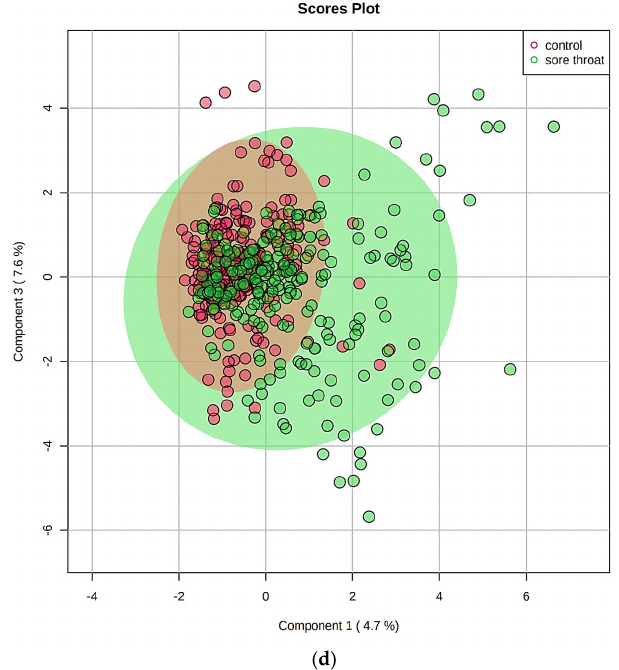
Figure 6. ( a ) and ( b ), 3D component 3 vs. component 2 vs. component 1 PLS-DA scores plots of the TSP-normalised 1 H NMR WMS supernatant dataset for exploring distinctions between participants with an acute sore throat condition (green crosses) and those in an age-matched healthy control cohort (red triangles); in total, 240 samples from each group were analysed, i.e., 5 sequentially collected daily samples from each of 48 participants per group. A total of 31 assigned and named biomolecule predictor variables were incorporated into this experimental design (Model 1). In ( a ), row-wise product quotient normalisation (PQN), with glog-transformation and column-wise Pareto-scaling were applied prior to analysis; ( b ), as ( a ), but with constant sum normalisation (CSN) applied in place of PQN. The % variance contributions for each PC are indicated for each model. ( c ), as ( a ), but with 183 ISB variables. ( d ), 2D component 3 vs. component 1 sPLS-DA scores plot of the complete 183 ISB variable 1 H NMR dataset for a model featuring 10 ISB predictor variables per component for a maximum number of 4 components (PQN, glog-transformation and Pareto-scaling were all applied to the MV dataset prior to analysis). This sPLS-DA analysis provided a high level of evidence for two separate sub-clusters of the sore throat group, one separate from the healthy control classification, the other appearing to co-cluster with it.